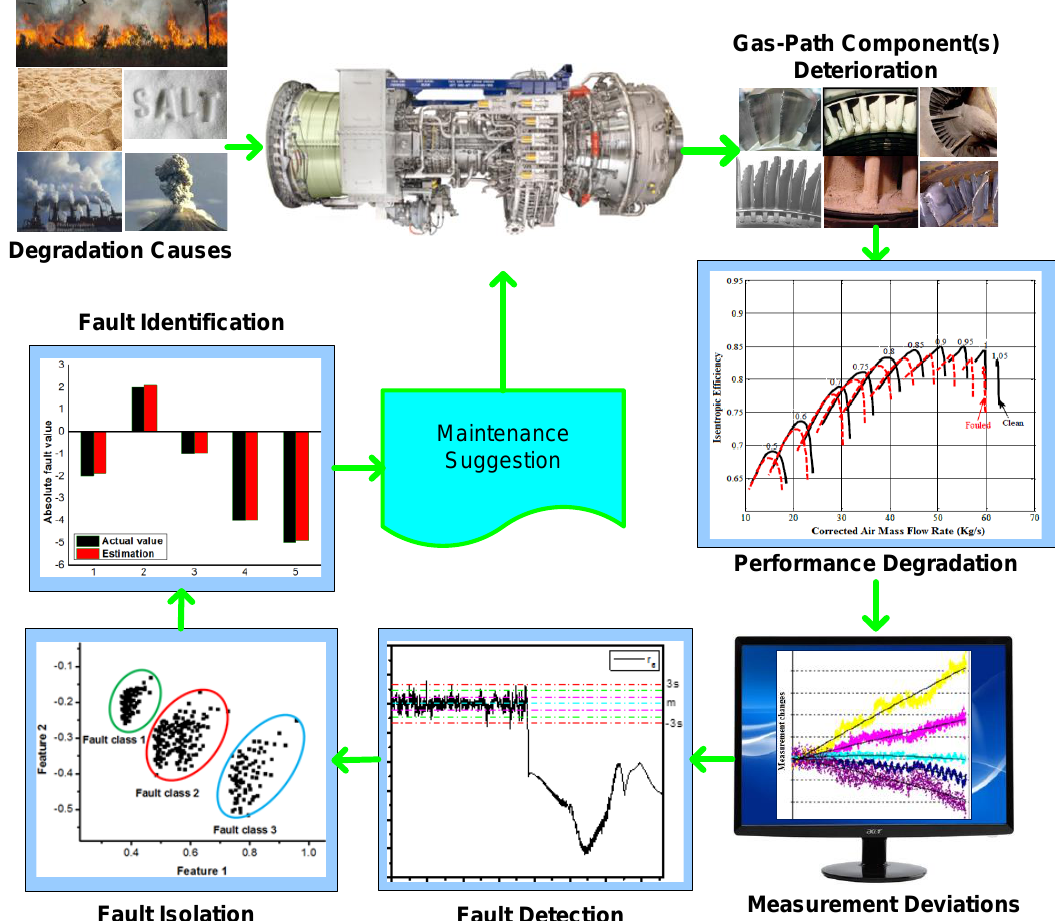
Figure 2. Conceptual model of a gas-path fault diagnostics (adapted from [72]). It shows gas turbine gas-path diagnostic steps: Ingestion of gas path degradation causes, performance deterioration, measurement deviation, and fault diagnostics.